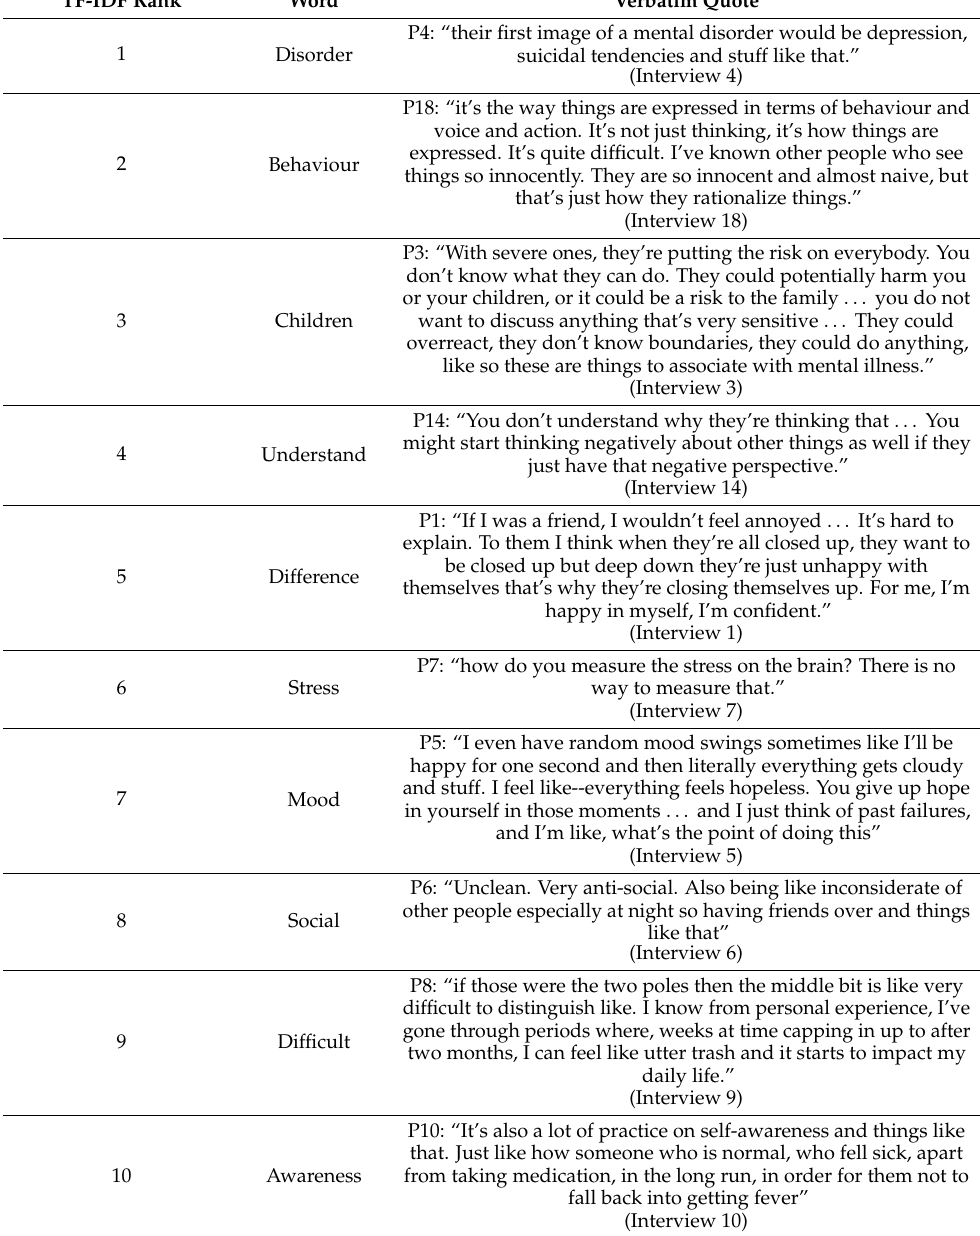
Table 5. Interview TF-IDF Rank Score Quote